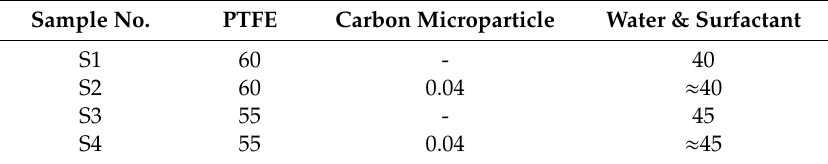
Table 1. Description of PTFE Dispersion (%) Based on di ff erent Compositions. Sample No.